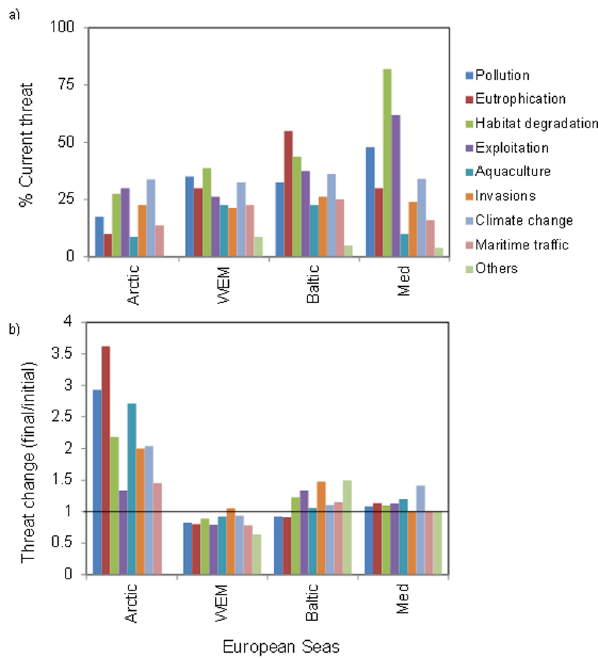
Figure 7. Qualitative ranking of potential threats to biodiver- sity from natural and human impacts. Threats were assessed for both A) current conditions and B) expected conditions in 10 years: the average value for each future threat was subtracted from the current perceived threat for comparison among regions. A negative value in the plot suggests predicted lessening of the threat (modified from Coll et al. [9] and Costello et al. [31]).